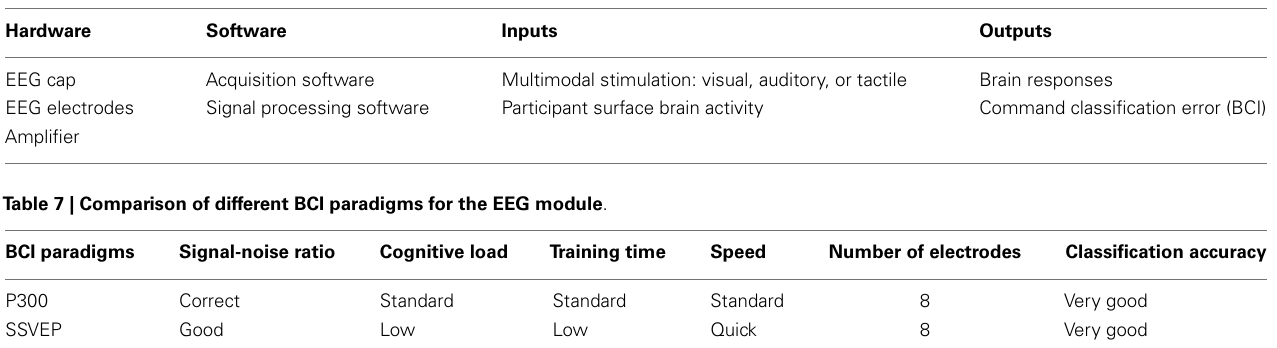
gUSBamp is connected to the PC via USB whereas the gMobiLab uses Bluetooth.To deliver physiological data to theVE and to synchronize these data with events from theVE we use the UDP network protocol both in MATLAB and in XVR/Unity.